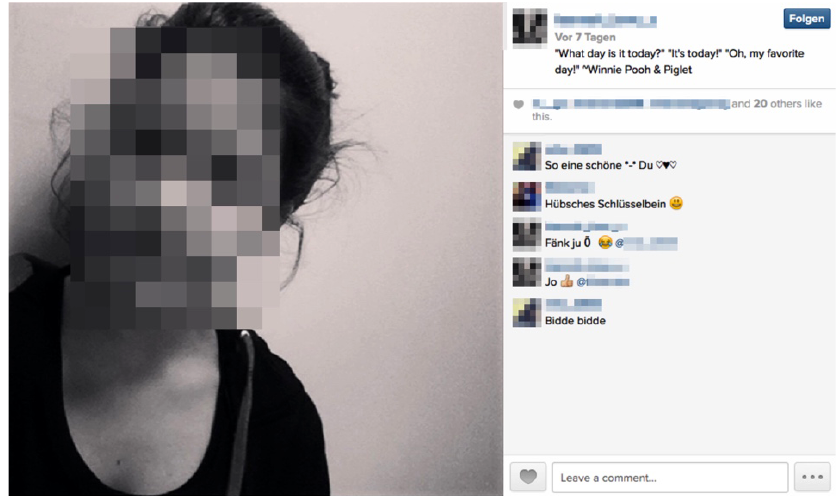
Figure 2. Screenshot from Instagram browser